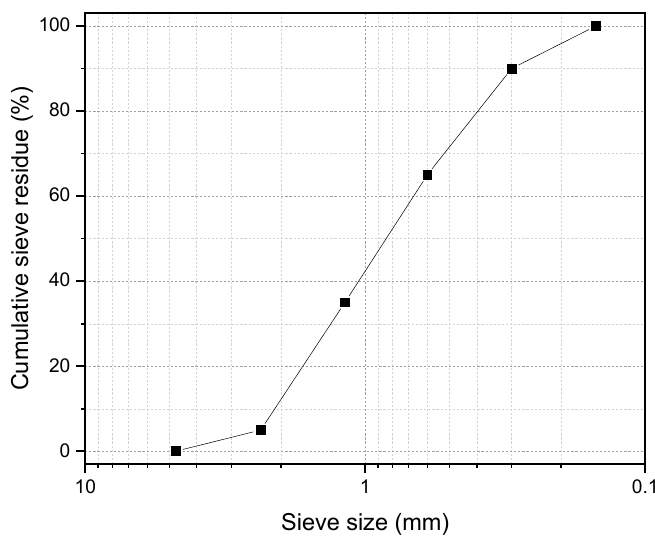
Figure 3. Particle gradation of recycled fine aggregate.